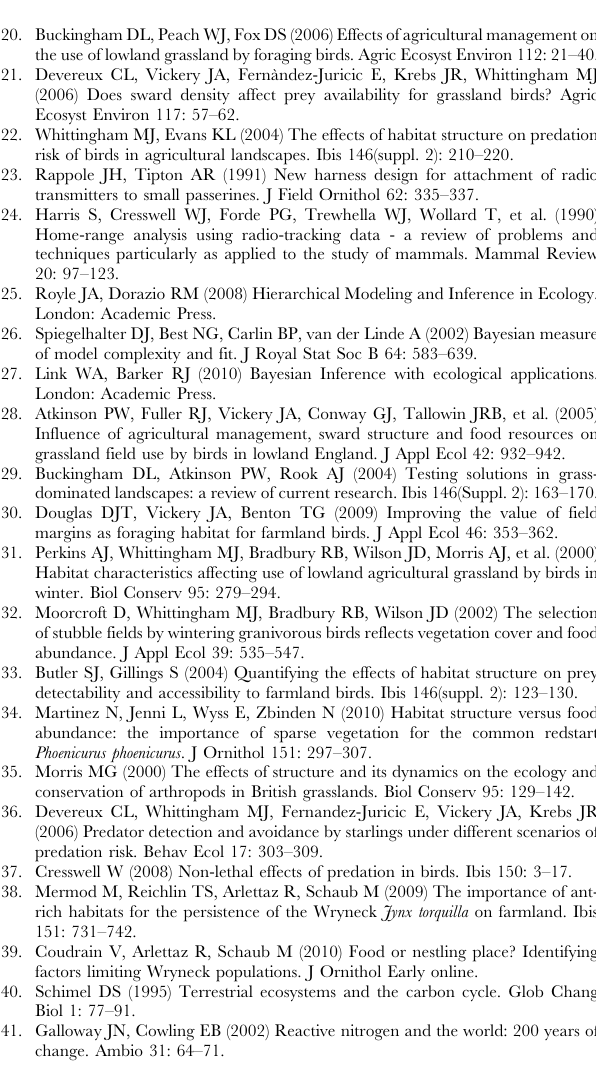
Figure S1 Selection probability of habitat use in relation to amount of bare ground and vegetation height for hoopoe and wryneck in different habitat categories as revealed by the most complex model. The grey lines show the individual effects, the black and blue line shows the population (marginal) average with 80% credible intervals. Note that selection probabilities below 0.5 indicate avoidance, selection probabilities above 0.5 indicate preference. Figure S2 Selection probability of habitat use in relation to the amount of bare ground and vegetation height for four farmland species as revealed by the best models (Table 1). The grey lines show the individual effects, the coloured lines show the population (marginal) average with 80% credible intervals. Note that selection probabilities below 0.5 indicate avoidance, selection probabilities above 0.5 indicate preference. Table S1 Sample sizes, locations and the use of radio-tags for the four studies: number of individuals, total number of observations and random points, and mean number of observa- tions and random points per individual.